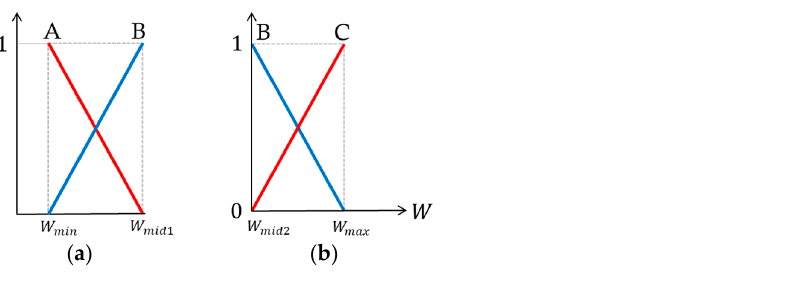
Figure 2. Fuzzy membership functions for lower and upper limits. ( a ) Lower limit (dec.), ( b ) lower limit (inc.), ( c ) upper limit (dec.), ( d ) upper limit (inc.).